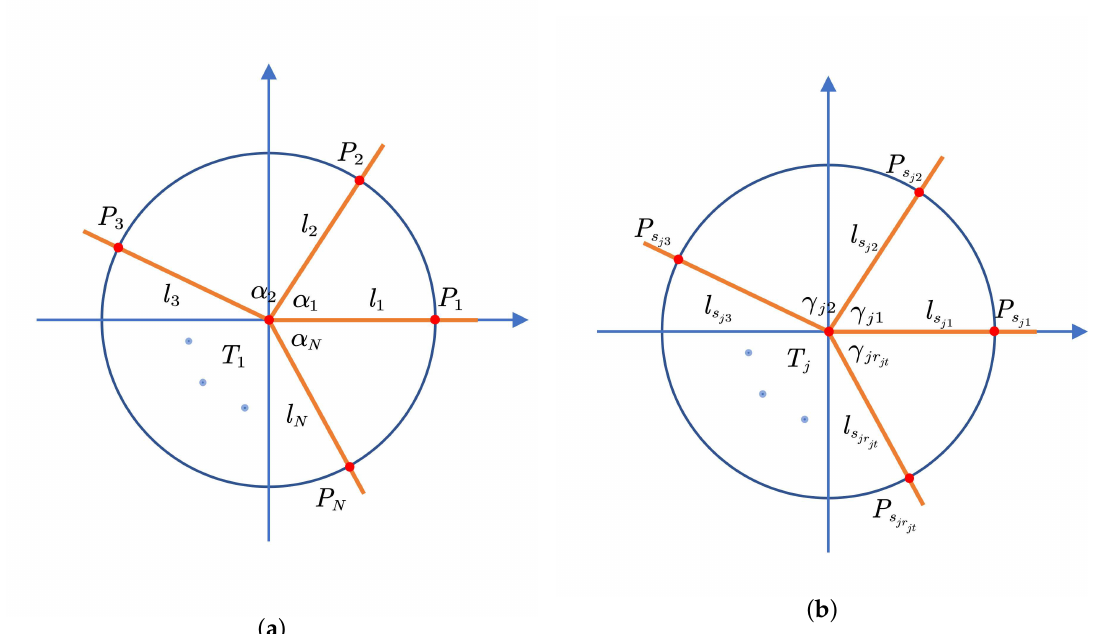
Figure A1. Establish the coordinate system with the user node as the origin. Draw the unit circle with the origin as the center. The points and angles defined by each link are as shown. Graph ( a ) denotes one target T 1 in the noncooperative scenario, and Graph ( b ) denotes the cooperative scenario, where one of the user nodes is T j